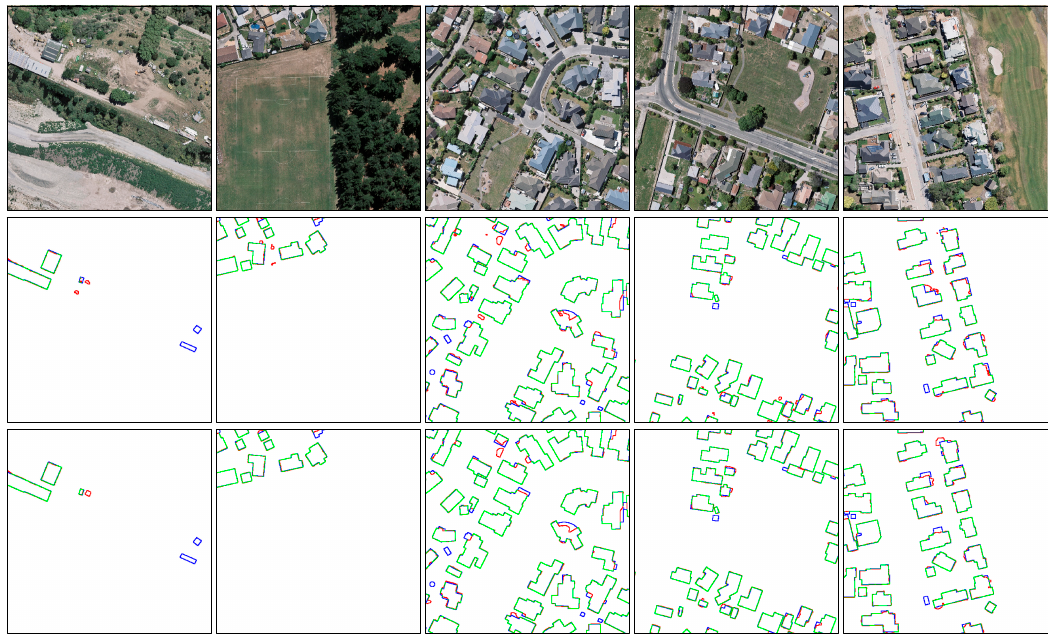
Figure 9. Examples of the building boundaries. The 2nd and 3rd are boundary maps predicted from images in the 1st row through the naive UNet and the UNet refined with the BP loss, respectively. Areas of green, red, blue, and white represent the true-positive, false-positive, false-negative and true-negative predictions, respectively.